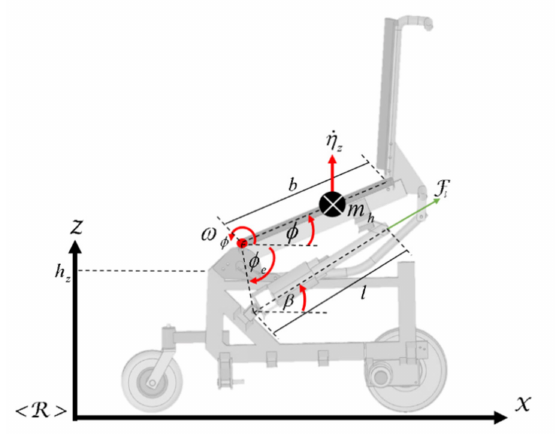
Figure 3. Linear movement of the standing wheelchair on the Z